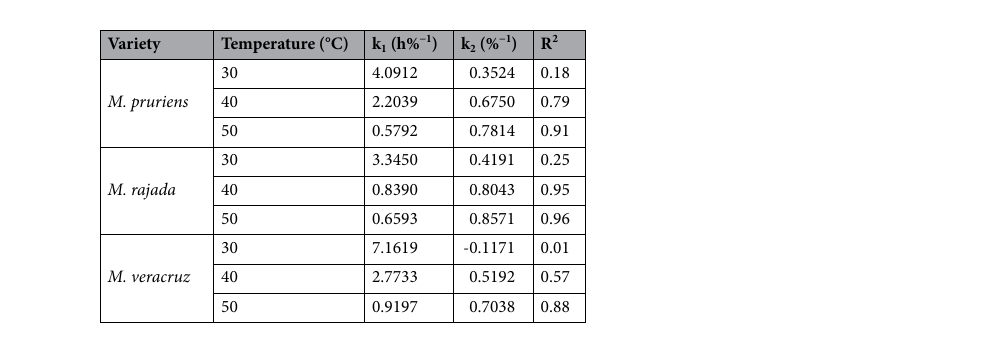
Table 2. Water absorption characteristics of Mucuna beans using Peleg’s model.